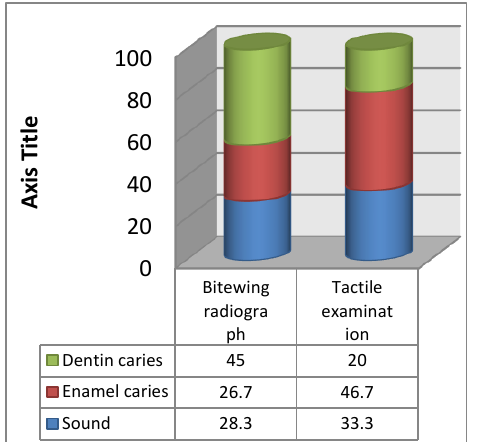
Figure9: Illustrated percentile value of different threshold of each techniques at occlusal